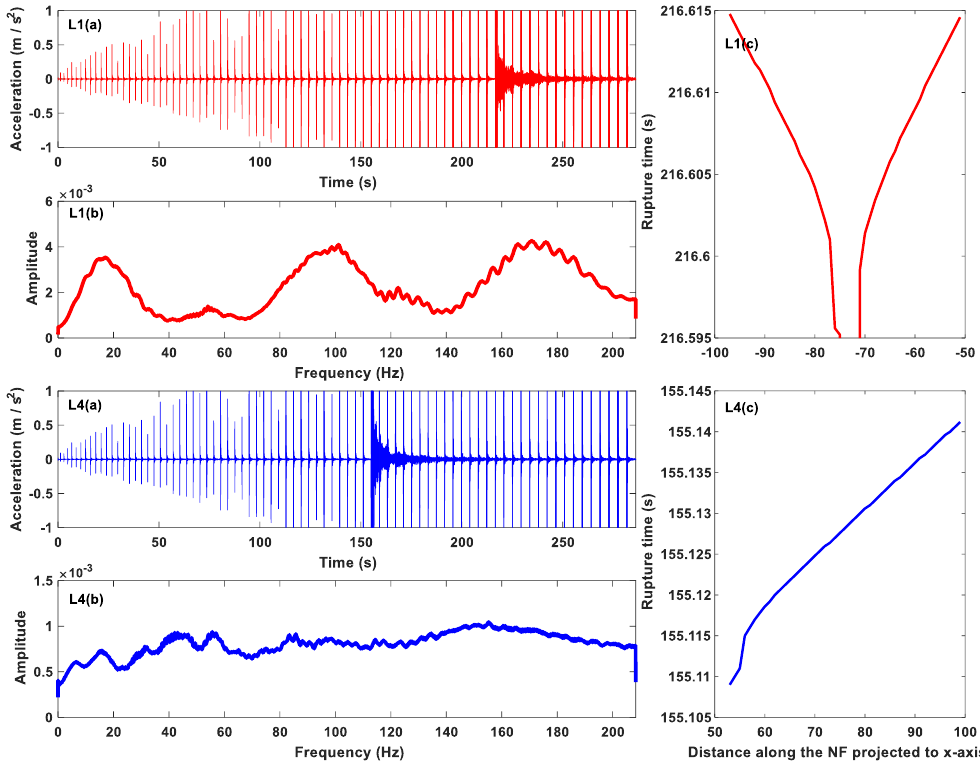
Figure 10—The x-component of the seismogram of the induced microseismicity, the spectrum and the rupture along the NFs in the two different models (i.e., L1 and L4). The top half is for the model with only the lower first (i.e., L1) NF, and the bottom half is for the model with only the lower fourth (i.e., L4)